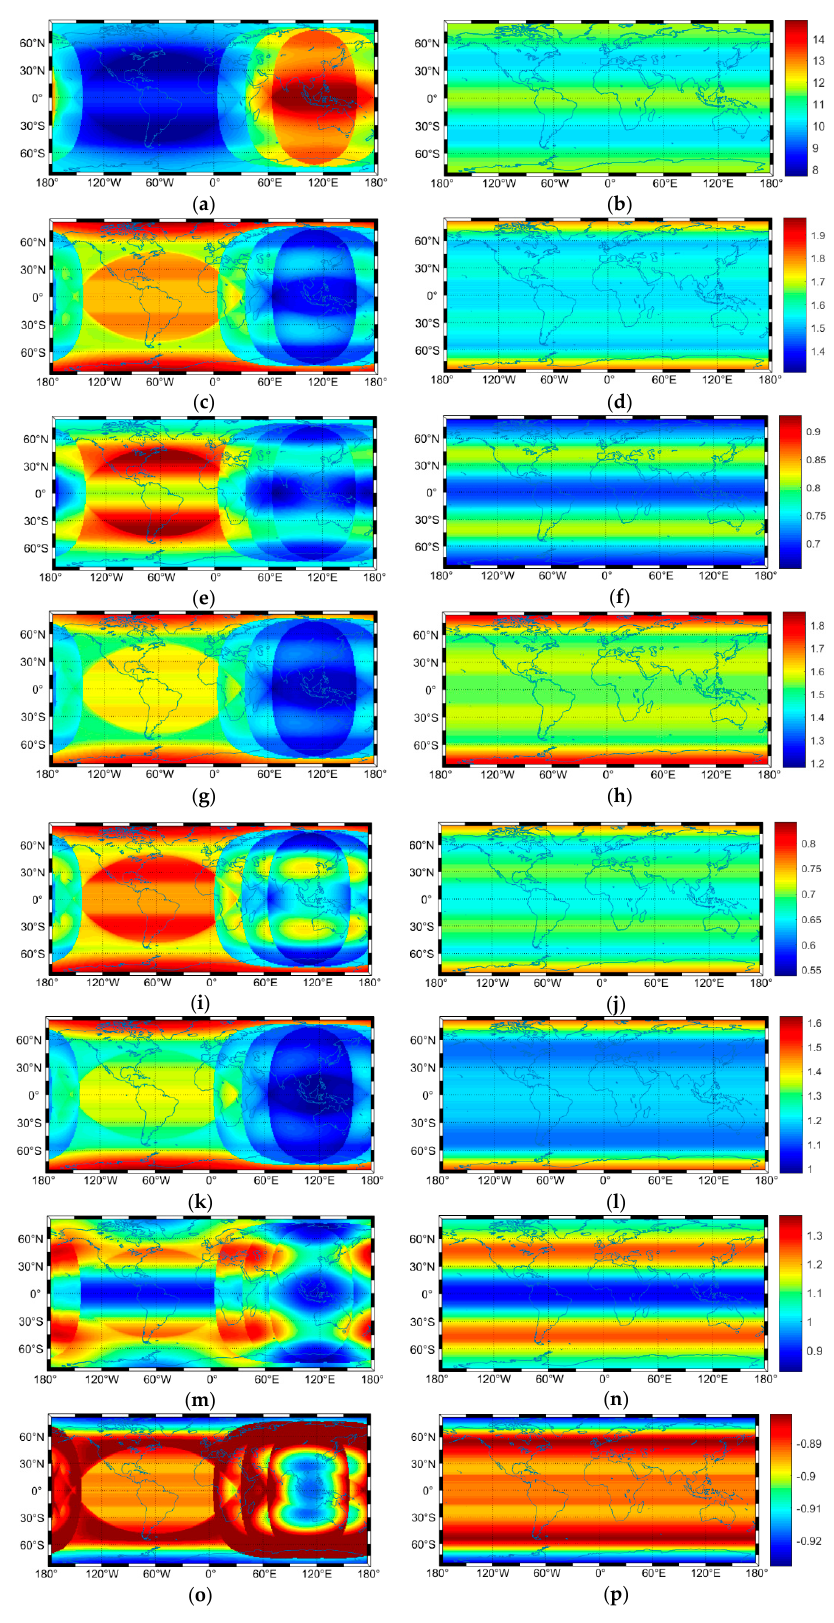
Figure 4. Estimated DOPs (GDOP (geometric DOP), HDOP (horizontal DOP), PDOP (position DOP), TDOP (time DOP), and VDOP (vertical DOP) ), positioning precision in longitude versus latitude, and correlation between station height and receiver clock difference of the BDS-3 and GPS constellation with 5° CEA. ( a ) Number of visible satellites BDS-3; ( b ) Number of visible satellites GPS; ( c ) GDOP of BDS-3; ( d ) GDOP of GPS; ( e ) HDOP of BDS-3; ( f ) HDOP of GPS; ( g ) PDOP of BDS-3; ( h ) PDOP of GPS; ( i ) TDOP of BDS-3; ( j ) TDOP of GPS; ( k ) VDOP of BDS-3; ( l ) VDOP of GPS; ( m ) The ratio of positioning precision between the longitude component and the latitude component of BDS- 3; ( n ) The ratio of positioning precision between the longitude component and the latitude component of GPS; ( o ) Correlation level between station height and receiver clock difference of BDS-3; ( p ) Correlation level between station height and receiver clock difference of GPS. From Figure 4a,b, we can find that the satellite visibility of GPS is more globally balanced than BDS-3, and for BDS-3, more satellites can be observed in the Asia-Pacific region while fewer satellites in the Western Hemisphere. From Figure 4c to Figure 4l, the DOPs of BDS-3 are larger than GPS in the Western Hemisphere. Note that VDOP is larger in high latitude regions, especially in the polar regions for both BDS-3 and GPS because, with an increase in station latitude, the elevation of satellites observed becomes lower. In this case, introducing HEO satellites into the GNSS constellation may make more satellites be observed, which might improve the geometry distribution in the vertical direction. As shown in Figure 4m,n, for the GPS constellation in most regions, the positioning precision in the longitude component is worse than for the latitude component. However, in contrast, for the BDS-3 constellation in some low latitude regions and some polar regions, the precision of the longitude component is better. The reason may be that GPS satellites are all MEO satellites, mainly flying along east-west direction so positioning precision is better in this direction. However, in the case of BDS-3, 3 IGSO satellites mainly fly along the longitude direction. Besides, the GEO satellites mainly contribute to DOP value in the longitude direction mainly [2]. For the correlation level between station height and receiver clock difference, as shown in Figure 4o,p, BDS-3 in augmentation area (60° S–60° N and 50° E–170° E) is slightly higher than GPS in the same area. This may be because